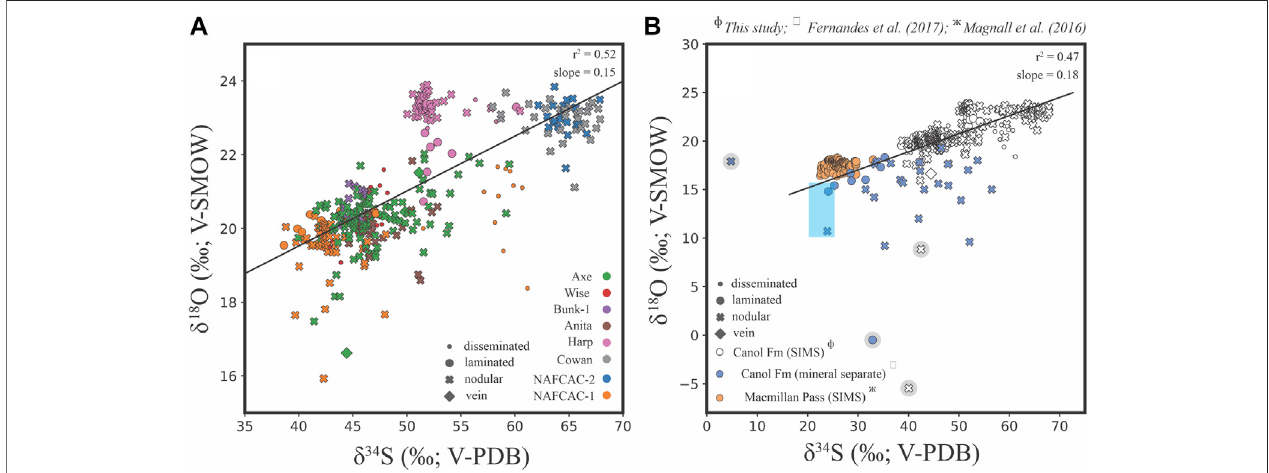
FIGURE 12 | (A) Bivariate plot showing δ 34 S values vs . δ 18 O values generated by SIMS analysis of barite from the Canol Formation. The regression analysis excludes the outliers that are highlighted in (B) . (B) Bivariate plot showing δ 34 S values vs . δ 18 O values for a compilation of Late Devonian barite data, including mineral separate analyses of Canol Formation barite (Fernandes et al., 2017) and SIMS analyses of barite from Macmillan Pass (Magnall et al., 2016). The regression analysis includes the SIMS and mineral separate data for Canol Formation barite but excludes the outliers from either dataset (highlighted by grey circles). The blue box represents the range of constraints for Late Devonian seawater (John et al., 2010; Chen et al., 2013).